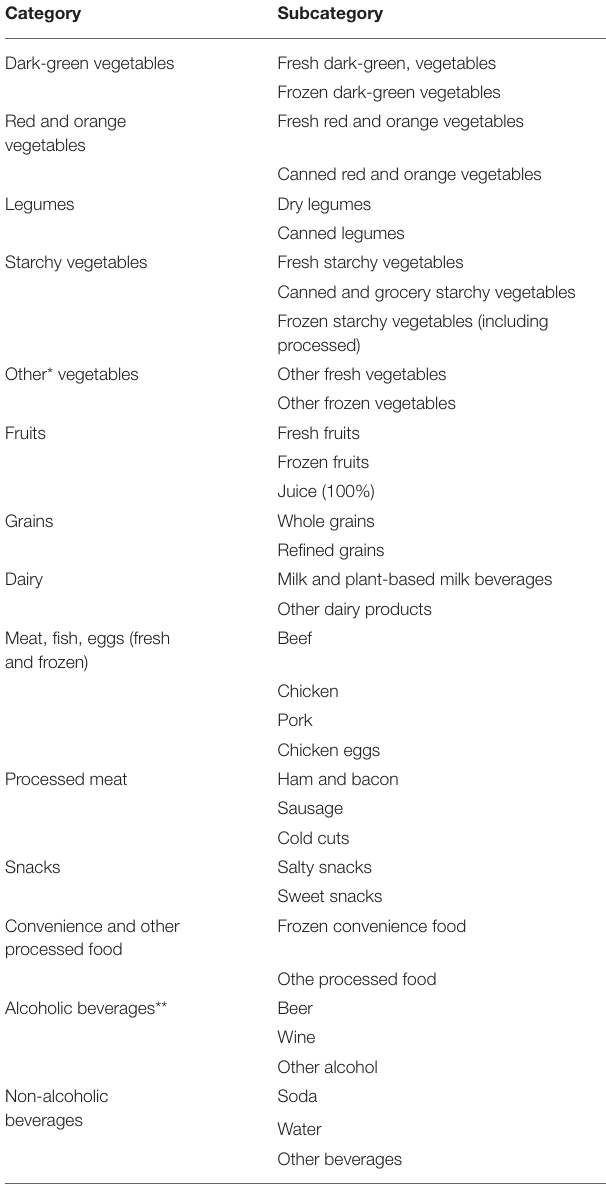
TABLE 3 | Food categories and subcategories applied in the processing of grocery store sales data, adapted from the 2015-2020 Dietary Guidelines for Americans (US Department of Health Human Services US Department of Agriculture,